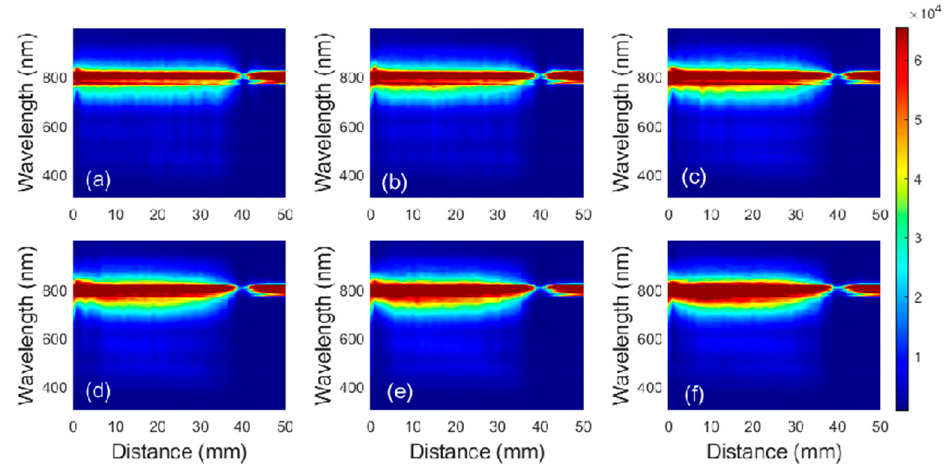
Figure 6. Variation of the SC induced by the filamentation of LG beams with D when the value of TC is ( a ) 0, ( b ) 1, ( c ) 2, ( d ) 3, ( e ) 4 and ( f ) 5. The incident pulse energy is 52 μ J.